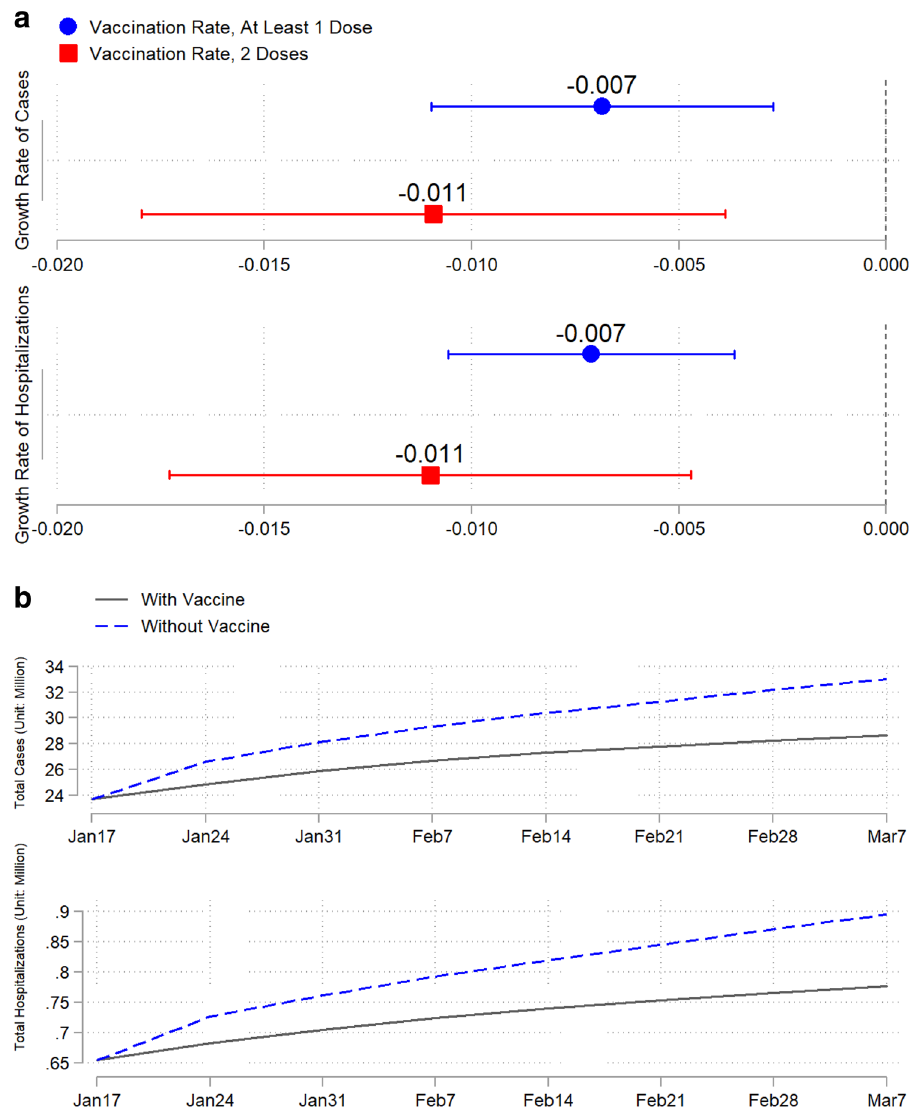
Figure 3. Estimated effects of vaccination on the COVID-19 pandemic. Blue markers are the estimated effects of at least 1 dose of vaccine, and red markers are the estimated effects of 2 doses of vaccine. ( a ) Baseline effect of vaccination on the growth rates of total cases and hospitalizations. ( b ) Estimated trajectories of total cases and hospitalizations without vaccines (dashed curves) versus actual trajectories of total cases and hospitalizations with vaccines (solid